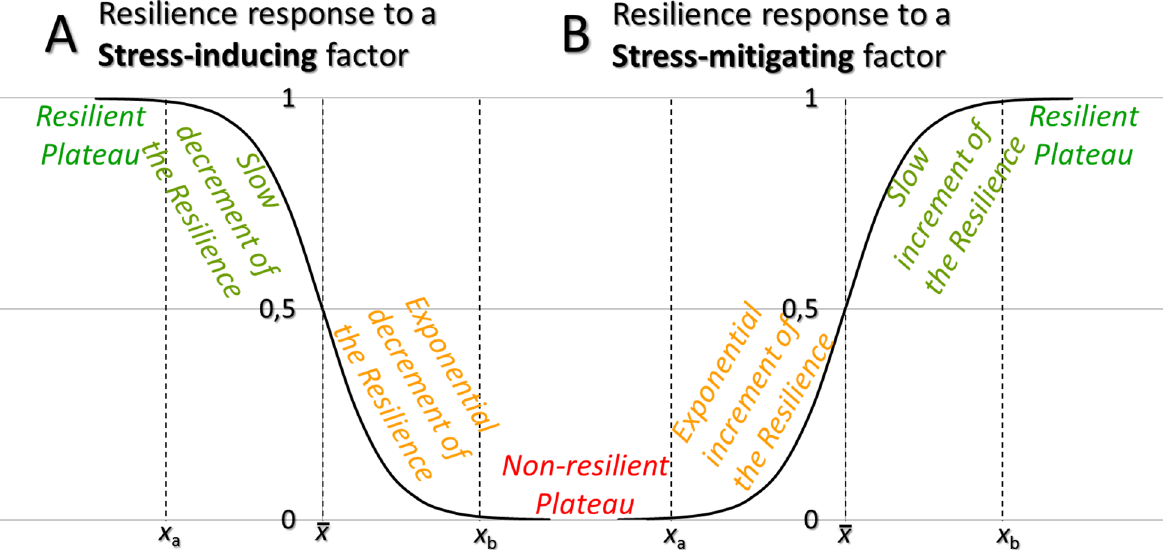
Figure 3. Resilience responses to factors modeled by ( A ) a decreasing logistic function and ( B ) an increasing logistic function when confronted by stress-inducing and stress-mitigating factors, respectively. A sequence of four phases can be described for each function: resilient, slow decrement/increment, exponential decrement/increment, and non-resilient. x a , x b and (cid:1876)̅ correspond to the minimum, maximum and the mean values of the factor at